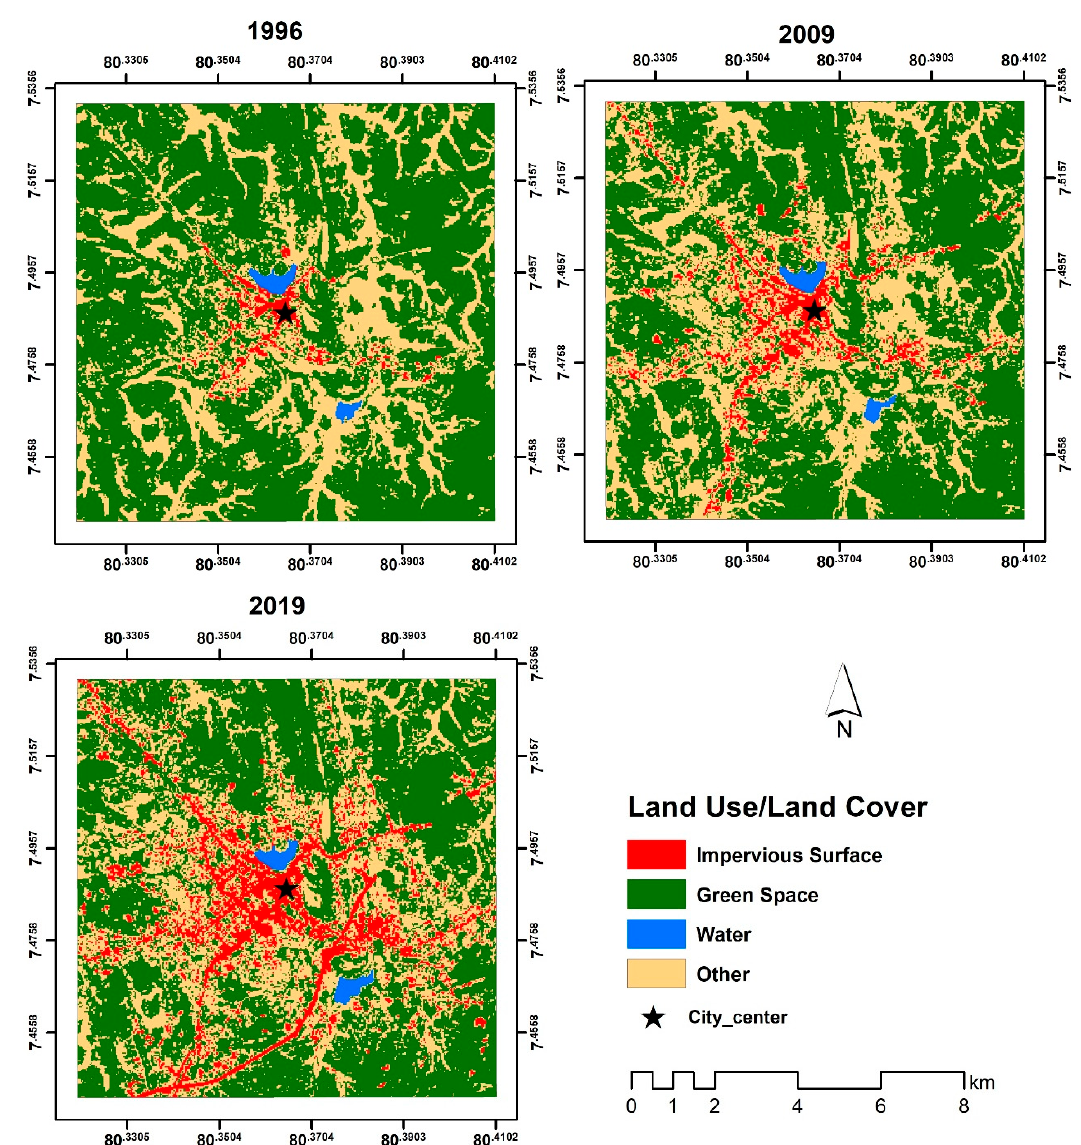
Figure 3. Land use land cover maps of the KUA for 1996, 2009 and 2019.